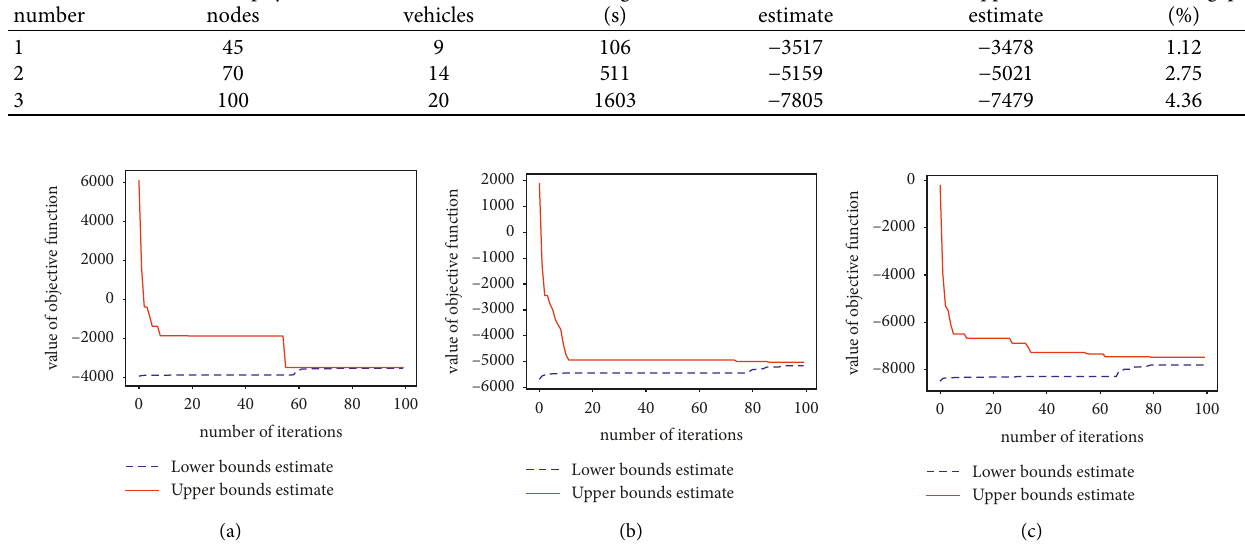
Figure 12: Iterative curve for cases with different case scales. (a) Iterative process for Case 1(45 physical nodes). (b) Iterative process for Case 2(70 physical nodes). (c) Iterative process for Case 3 (100 physical nodes).